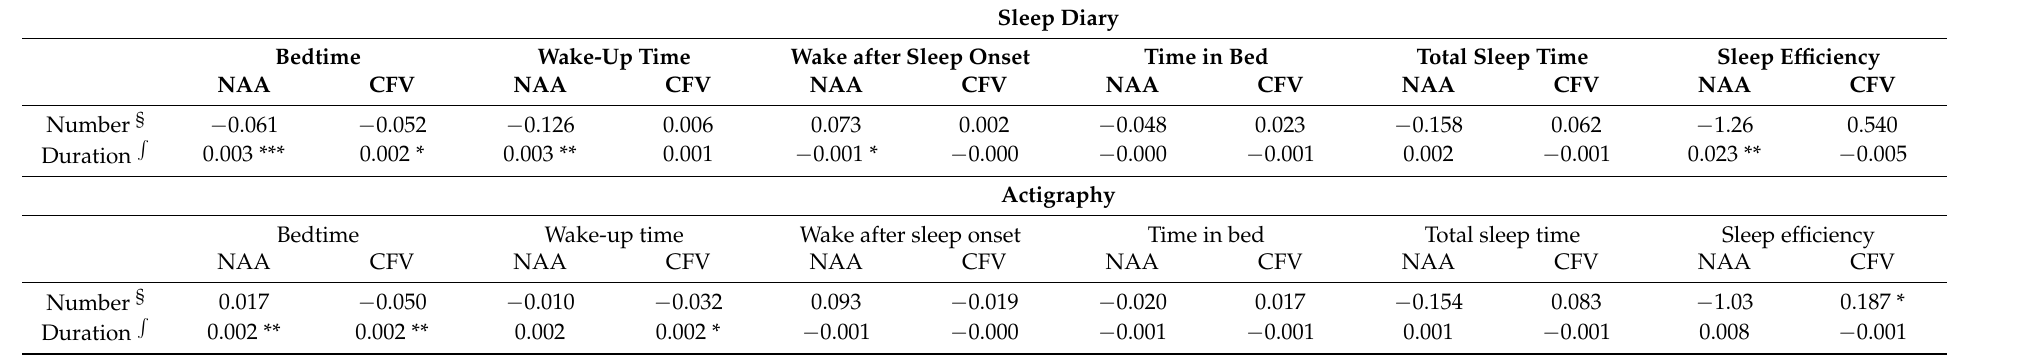
Table 3. The effect of missions on sleep variables in pilots from the Norwegian Air Ambulance (NAA; n = 25) and Christophorus Flugrettungverein (CFV; n = 22), derived from sleep diary and actigraphy, reported in unstandardized beta